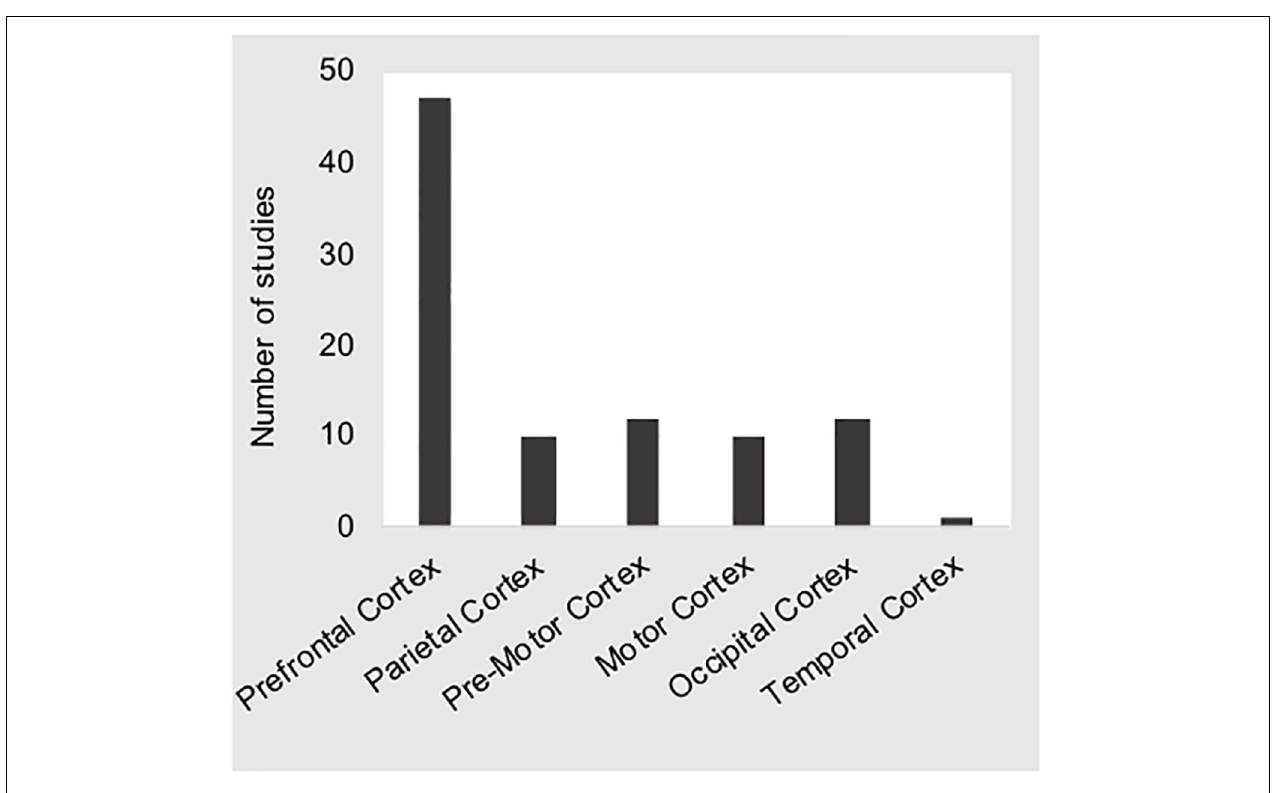
FIGURE 4 | The bar chart shows the number of studies reporting coverage of the regions of interest given along the x -axis. These distributions show that the majority of studies sampled prefrontal cortical regions.